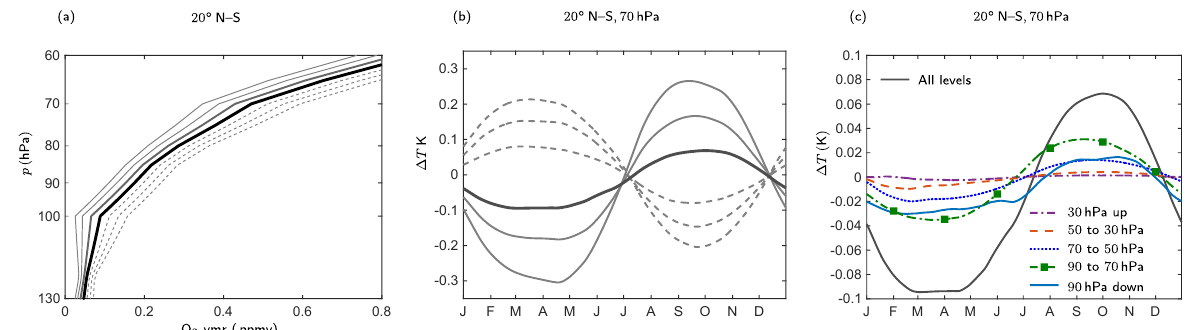
Figure C1. (a) Annual mean ozone profile averaged between 20 ◦ N and 20 ◦ S (middle solid black line). Solid dark grey line to the left of the middle line shows an illustrative perturbation to the annual mean profile where the ozone background value is decreased. Solid grey lines represent negative perturbations 2 times and 3 times this perturbation. Corresponding positive perturbations are shown as dashed lines. (b) Difference to the SEFDH temperature change at 70hPa for the annual ozone cycle due to the different annual mean ozone values in (a) . The darker solid grey line shows the temperature change for the illustrative perturbation. The lighter grey lines and dashed lines correspond to the increasingly larger negative and positive perturbations respectively, as shown in (a) . (c) The contribution of different ranges of pressure levels to the temperature change for the illustrative